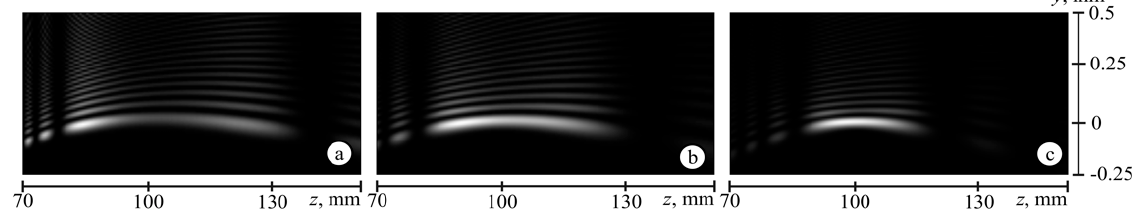
Figure 7. PSF longitudinal distribution patterns with a CoC size limit of 0.04 mm, α = 0.0015 for a lens with phase apodization n = 3 ( a ), n = 4 ( b ), and n = 5 ( c ), for λ = 550 nm.